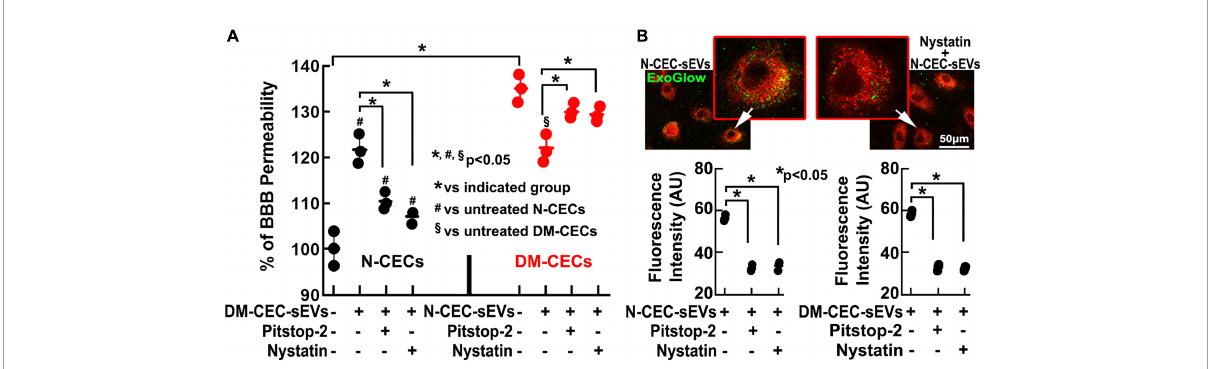
FIGURE6 DM-CEC-sEVs increase healthy CEC permeability, whereas N-CEC-sEVs reduce DM-augmented permeability. Blockage of clathrin- and caveolin-pathways abolishes the effects of sEVs on CEC permeability. Quantitative data (A) of endothelial monolayer barrier permeability assay in N-CECs with and without DM-CEC-sEVs, and in DM-CECs with and without N-CEC-sEVs in the presence and absence of endocytosis inhibitors. Representative images and quantitative data (B) of sEVs internalization by N-CECs in the presence and absence of endocytosis inhibitors. * p < 0.05 versus indicated